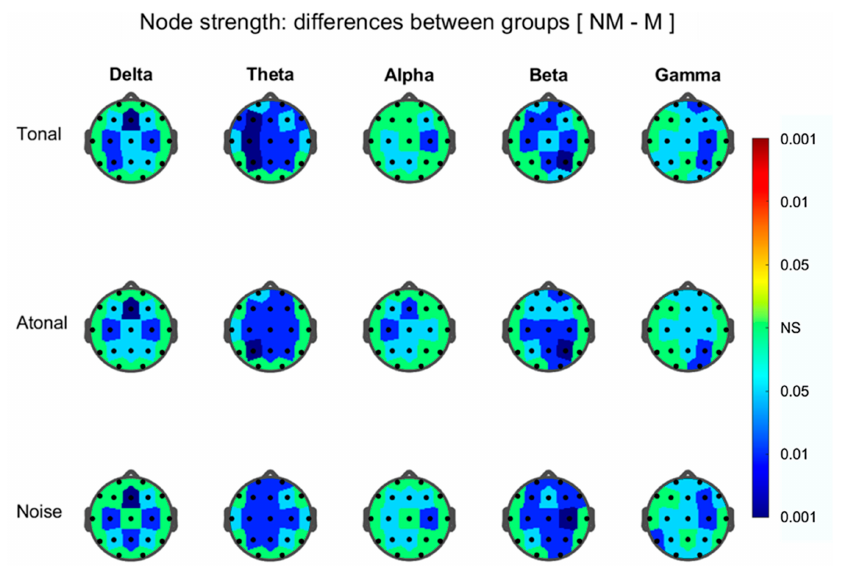
Figure 11. As in Figure 9 but for the difference between non-musicians (NM) and musicians (M) of node strength, during the three auditions indicated at left. Brain Sci. 2021 , 11 , x FOR PEER REVIEW